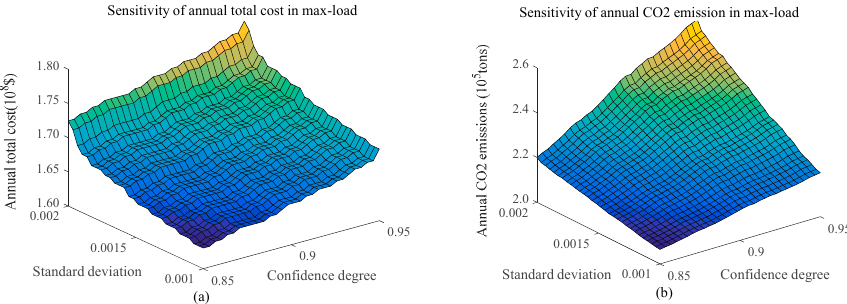
Figure 8. Analysis of IESs sensitivity under maximum reference load in 2026 ( a ) annual total cost; ( b ) annual carbon dioxide emissions.